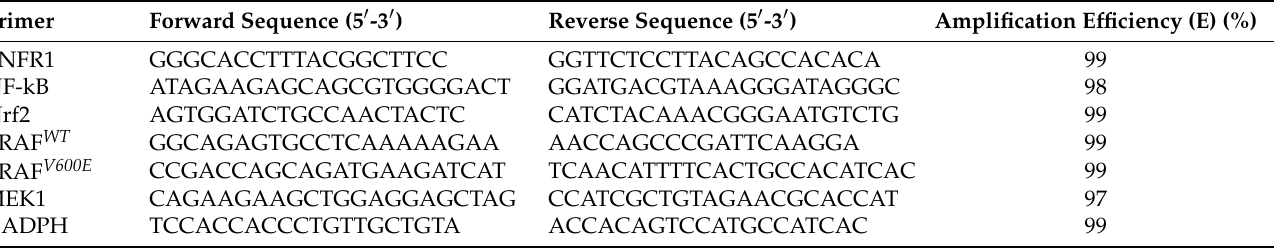
Table 2. Primers used in this study and their amplification